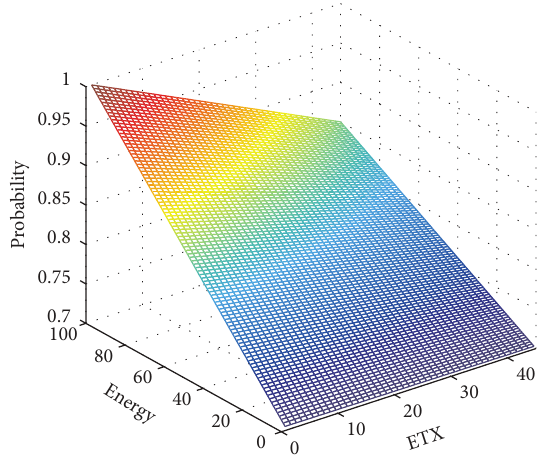
Figure 2: Forwarding probability via ETX and residual